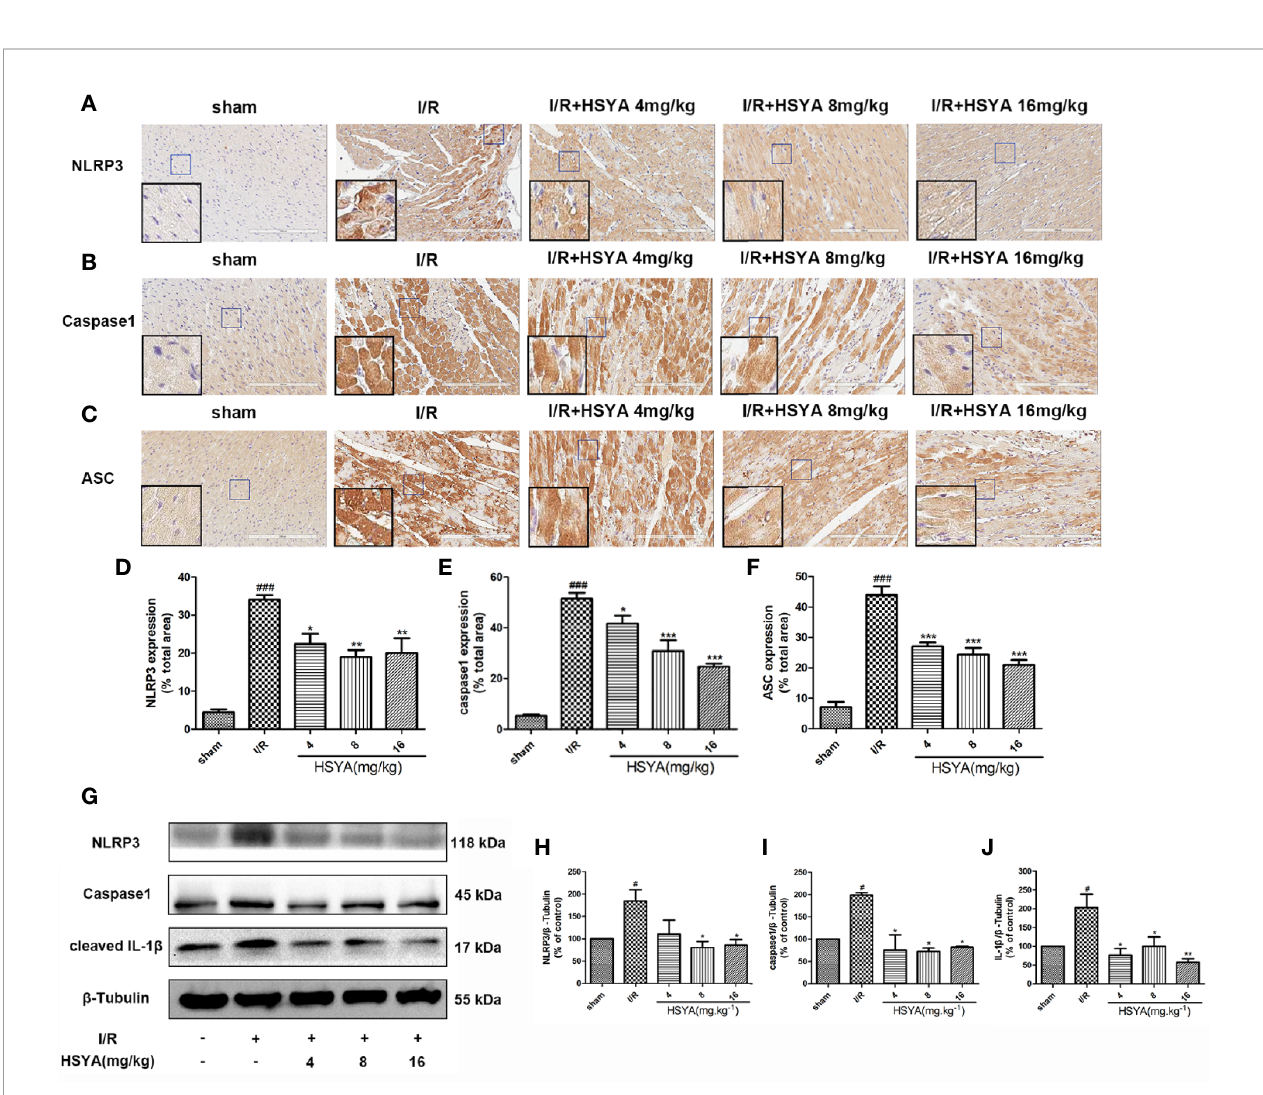
FIGURE 4 | Hydroxysaf fl or yellow A (HSYA) inhibits the expression of NLRP3 in fl ammasome. (A – C) Immunohistochemical staining measuring NLRP3, ASC, and caspase-1 expressions in heart tissues of rats. (D – F) Quanti fi cation of NLRP3, ASC, and caspase-1 staining. (G) Western blot showing the protein expression levels of NLRP3, caspase- 1, and cleaved interleukin (IL)-1 b . (H – J) The ratios of NLRP3, caspase-1, and cleaved IL-1 b and b -tubulin were quanti fi ed by densitometry based on immunoblot images. Data are presented as means ± SEM. # P < 0.05, ### P < 0.01 vs . the sham group, *P < 0.05, **P < 0.01, *** P < 0.001 vs . the ischemia/reperfusion (I/R)